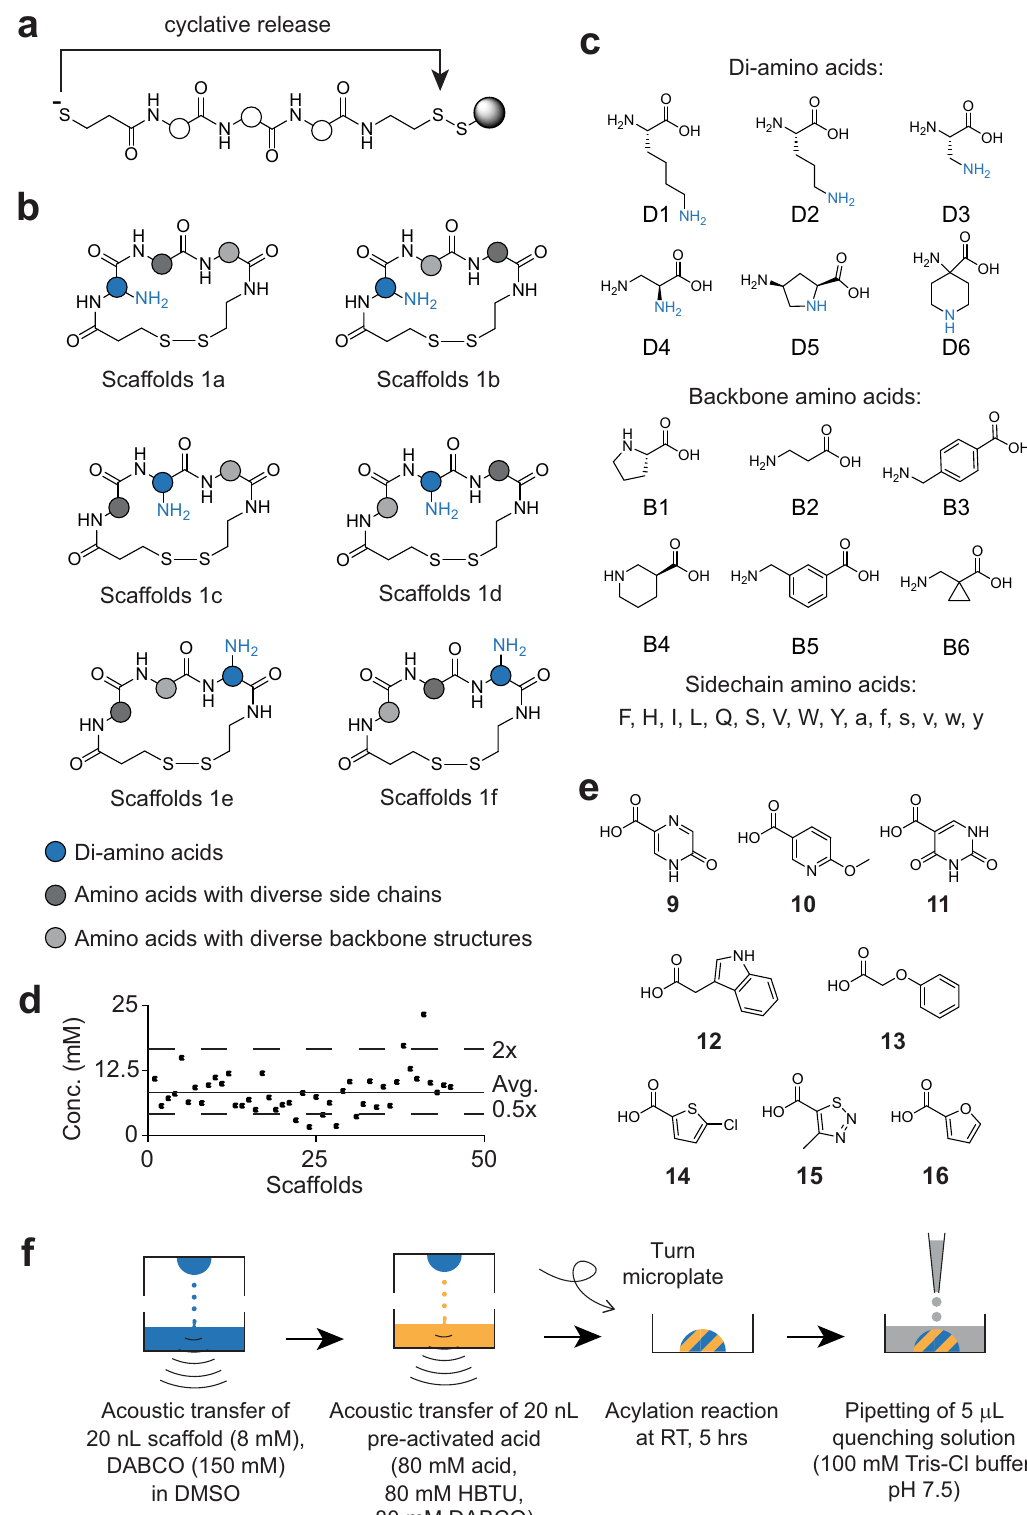
Fig. 2 Acylation of amines in macrocyclic scaffolds and library generation. a Cyclative disul fi de release of side-chain-deprotected peptides. b Formats of cyclic peptide scaffolds. Amino groups are shown in blue. c Amino acids used for scaffold synthesis. Lower case letters indicate D-amino acids. d Yields of the 45 tryptophan-containing scaffolds as determined by absorption measurement. e Carboxylic acids 9 – 16 that were used with acids 1 – 3 and 8 to diversify the scaffolds shown in panel b . f Schematic of the protocol for macrocycle library synthesis by acoustic liquid transfer with indicated reaction conditions.